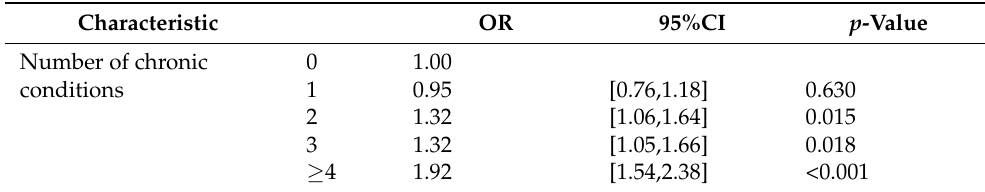
Table 2. Prospective association between the number of chronic conditions at baseline and falls at follow-up estimated by multivariable logistic